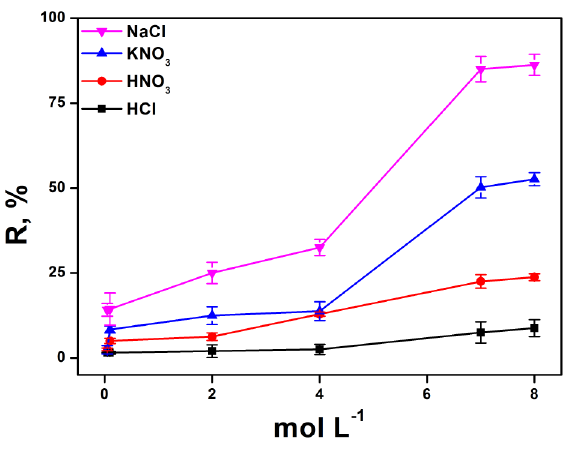
Figure 3: Effect of different concentrations of different reagents on the regeneration of biosorbent. The percentage recovery (R, %) is calculated by concentration after preconcentration/concentration before